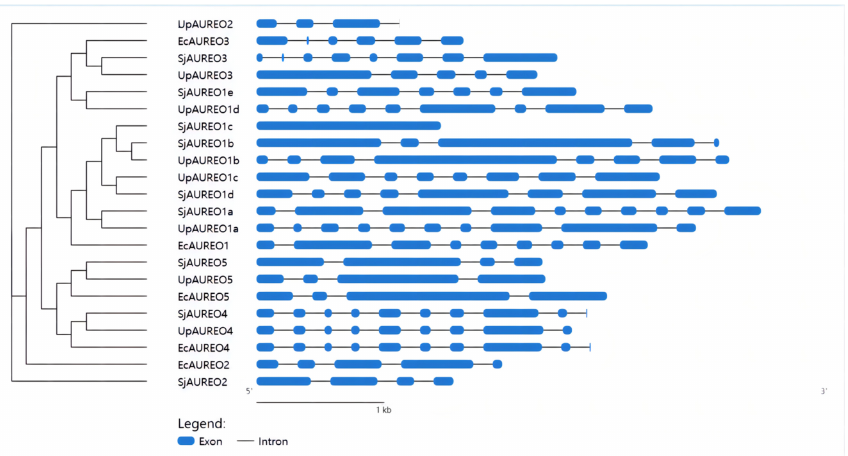
Figure 2. Structures of AUREO gene family members in E. siliculosus , S. japonica, and U. pinnatifida . The exact location of the exons/introns of each AUREO gene was determined from the information collected on the AUREO genes and visualized in pictures. Exons are shown as blue areas, and black lines indicate introns. 2.3. Phylogenetic Analysis and Classification of the AUREO Gene Family To further explore the evolutionary relationship of AUREO genes between S. japonica and other six stramenopiles species, an unrooted phylogenetic tree was constructed based on the 44 AUREO proteins from the above seven algae. The 16 previously named AUREO proteins were marked in red. The newly identified 28 AUREO genes (four of S. japonica , eight of U. pinnatifida , seven of C. okamuranus , and nine of N. decipiens ) were named ac- cording to their evolutionary relationship revealed by the phylogenetic tree (Figure 3), with a revision of Sj AUREO1 into Sj AUREO1a [33]. Based on 16 AUREO proteins iden- tified previously, the identified ARUEO were clustered into five groups (Figure 3). Group I was further divided into three subgroups, i.e., subgroup IA, subgroup IB, and subgroup IC. Subgroup IA (yellowish) was the largest one, including two AUREOs from C. okamura- nus , four from S. japonica , three from U. pinnatifida , two from N. decipiens, and one from P. tricornutum . Subgroup IB and subgroup IC contained four and five AUREOs, respectively. For the other four AUREO groups, group II contained 8 AUREOs of the AUREO2 sub- family, group III contained 6 AUREOs of the AUREO3 subfamily, group IV contained 4 AUREOs of the AUREO4 subfamily, and group V contained 5 AUREOs of AUREO5 sub- family. These four groups were clustered in another large subfamily distinct from the AU- REO1 subfamily, with all three large brown algae ( E. siliculosus , S. japonica , U. pinnatifida ) present with closely related AUREO2/3/4/5 protein members with high confidence (Boot- strap value >98). A total of nine AUREO proteins were identified in S. japonica , and they were distributed in all subgroups except subgroup IB, among which subgroup IA was the most distributed, with a total of 4 AUREOs proteins.